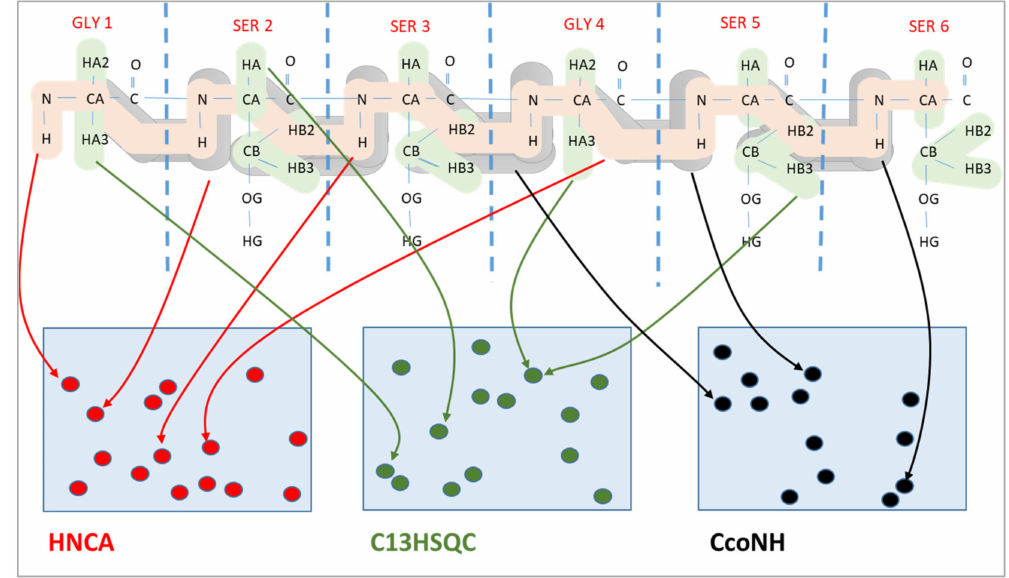
Figure 1. Chemical shift assignment by mapping expected peaks (colored atom patterns in the upper part) to the measured peaks (in the lower part) in three different